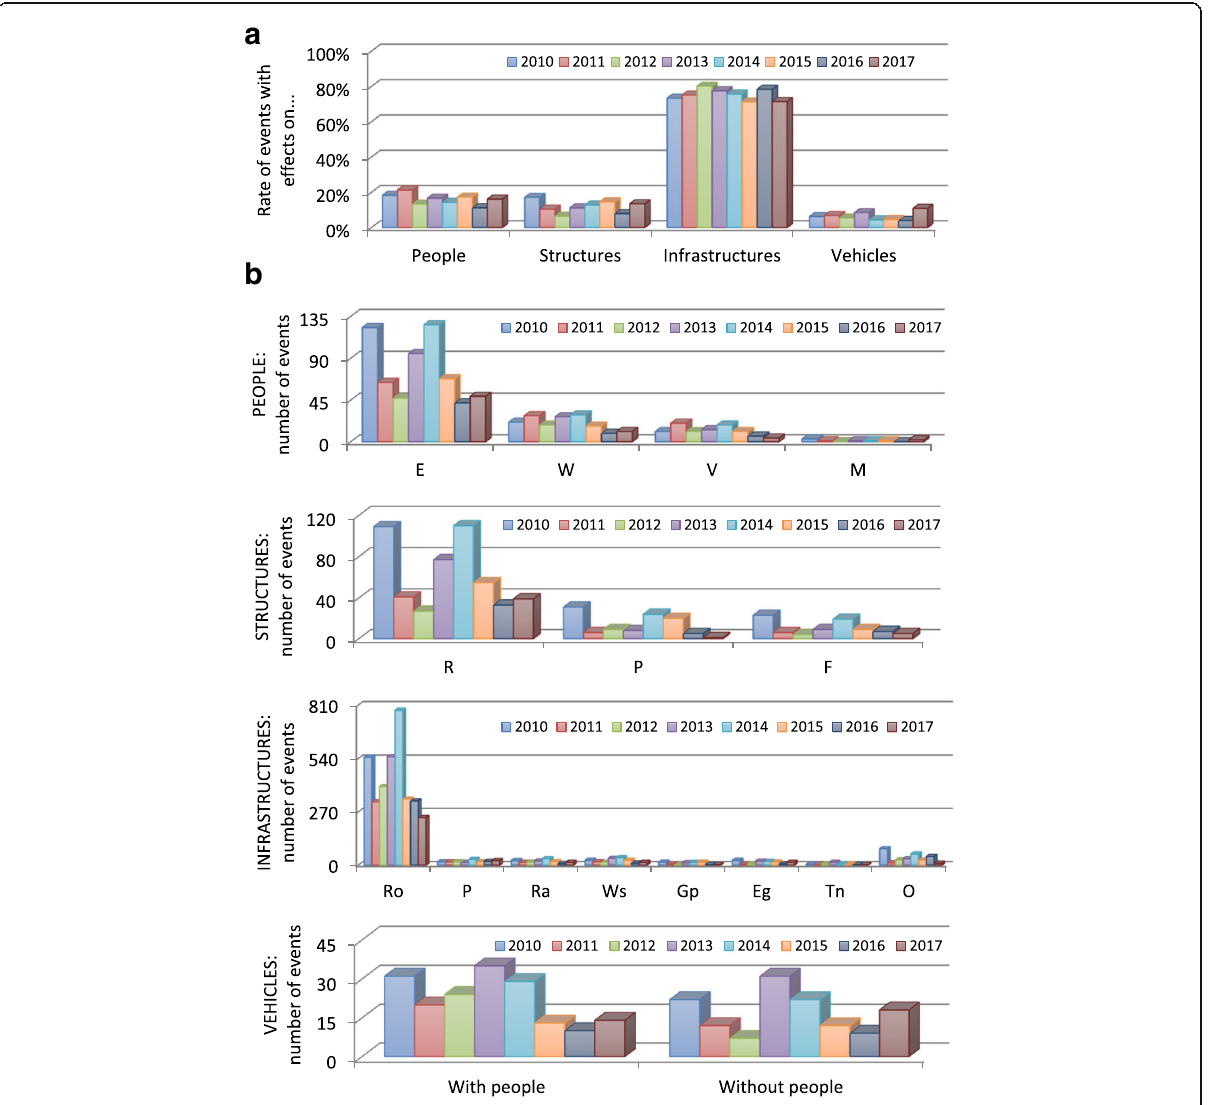
Fig. 7 Percentage of landslide events: ( a ) by year and category of consequences, i.e. people, structures, infrastructure and vehicles; ( b ) by year and subcategories of consequences. (Legend: E=evacuated; W=wounded; V=victims; M=missing; R=residential; P = public; F = factories; Ro = roads; P = paths; Ra = railways; Ws = water supplies; Gp = gas pipelines; Eg = electricity grids; Tn = telephone networks; O =